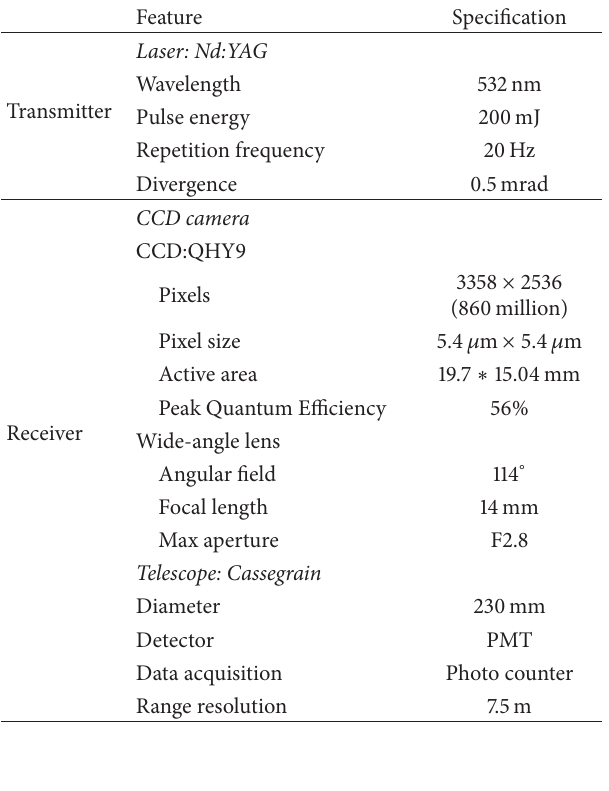
Table 1: Key specifications of the dual field of view lidar.